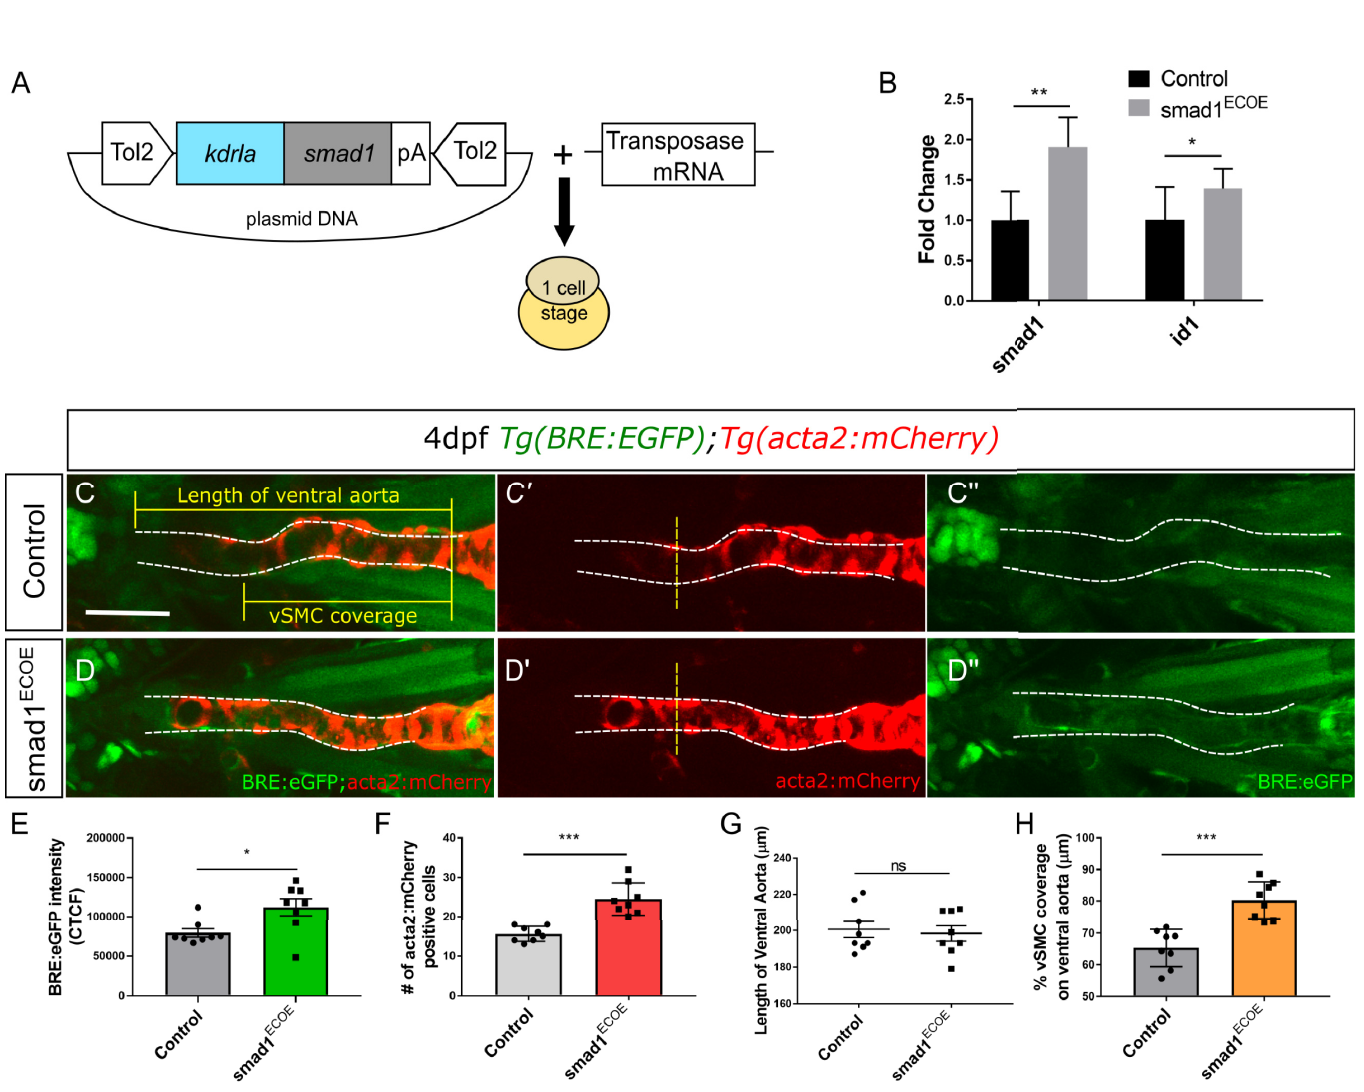
however the BRE : EGFP signal extends further along the ventral aorta (Fig 6C”, 6D” and 6G).